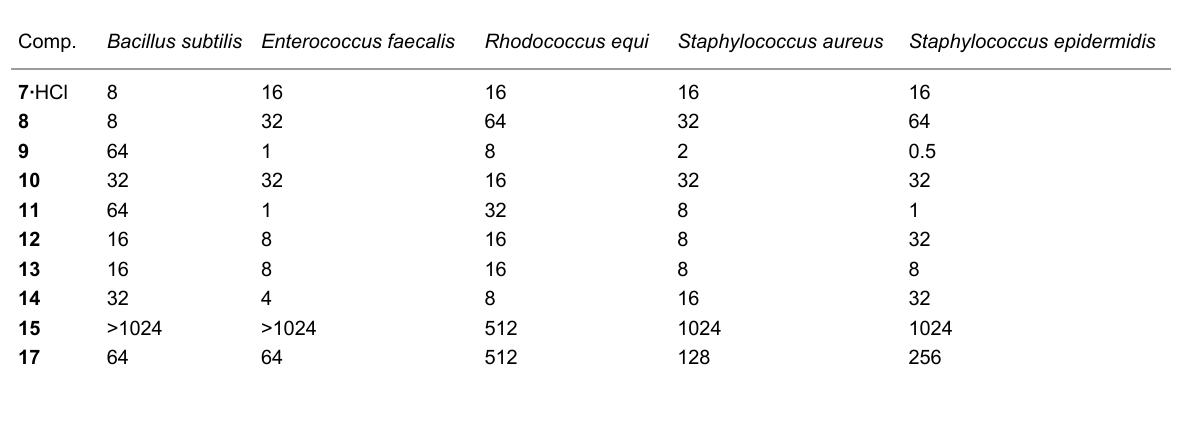
Table 2: Minimum inhibitory concentration (MIC) [ μ g/mL] for 8 – 15 and 17 against the Gram-positive bacteria.